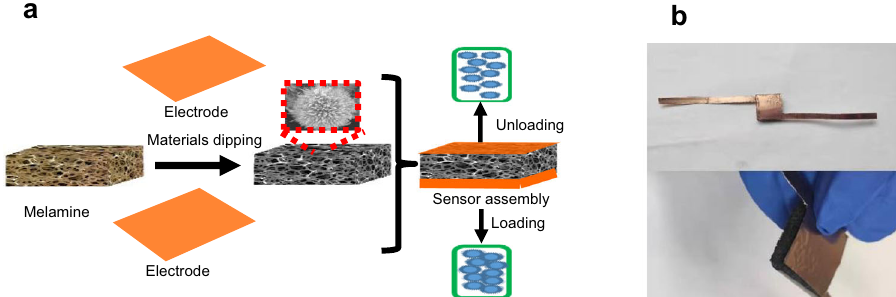
Fig. 1 Preparation diagram and sensor images. a Schematic illustration of the fabrication of the pressure sensor. b Images of the pressure sensor encapsulated with a copper